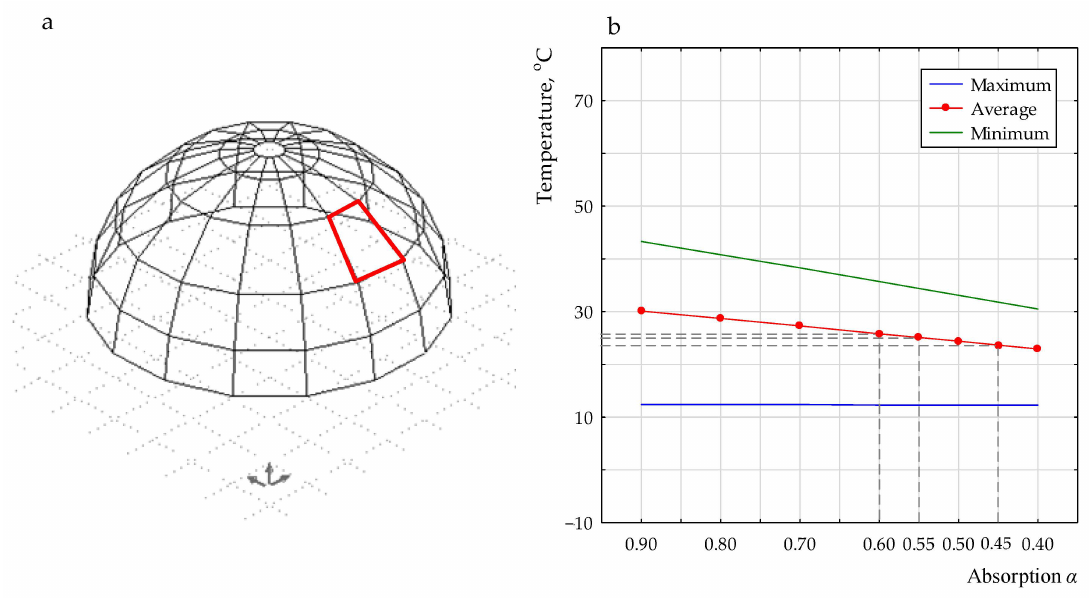
Figure 7. ( a ) Numerical model and ( b ) surface temperature (N_45 ◦ ) on 5 July obtained in the simulation.